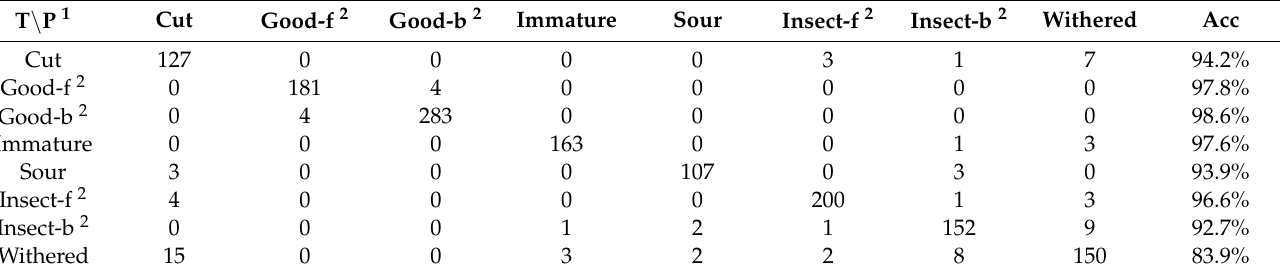
Table 9. Confusion matrix of the new network-dr-pv